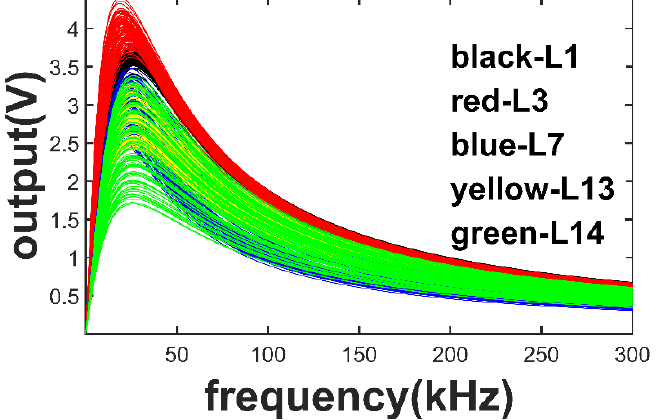
Figure 6. The curve of the influence of parameter m on accuracy under two kinds of fault parame- ters. As shown in Table 7, the search range of all classifiers is [0.001, 1000], the population size is 20, and the maximum number of iterations is 50. The fuzzification parameter m is set to 3.9 and 4.3, respectively. The feature frequency points are {20.421, 20.121, 19.820, 8.109, 2.103, 1.802, 1.502} kHz and {31.832, 31.532, 31.232, 23.124, 22.823, 21.622,21.322}